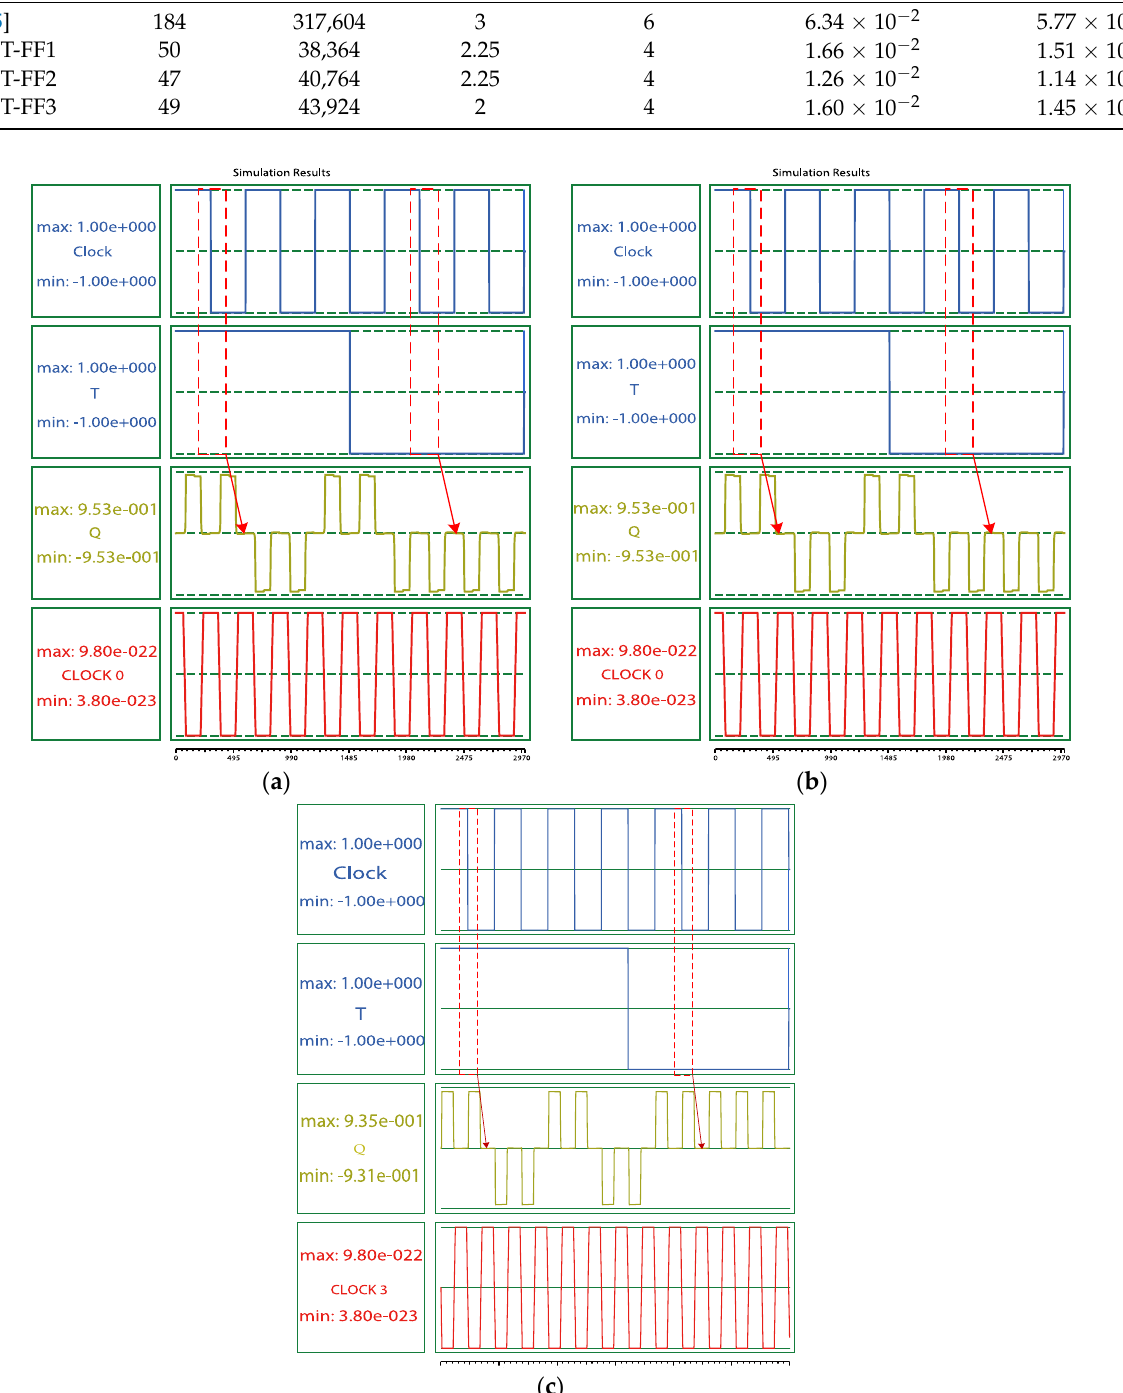
Figure 12. The simulation results of proposed NET-FFs. ( a ) NET-FF1, ( b ) NET-FF2, and ( c ) NET-FF3. Table 5. Comparisons of the performance and energy dissipation for alternative LST-FFs and NET- FFs.